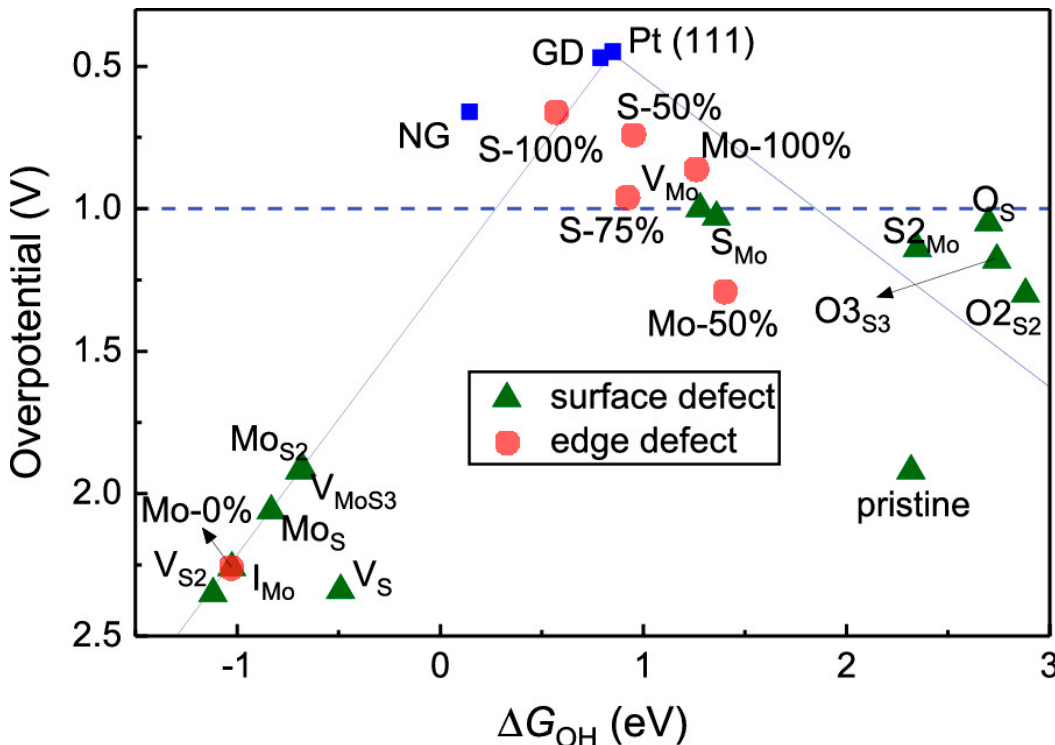
Figure 3. Relationship between overpotential of ORR process and Δ G OH ( Δ G OH is adsorption free energies for the OH adsorbates intermediating the ORR processes) for defective MoS 2 . The data for graphene defect (GD), Pt(111), and N-doped graphene (NG) are provided for comparison. Reprinted (adapted) with permission from [23]. Copyright (2019) American Chemical Society.